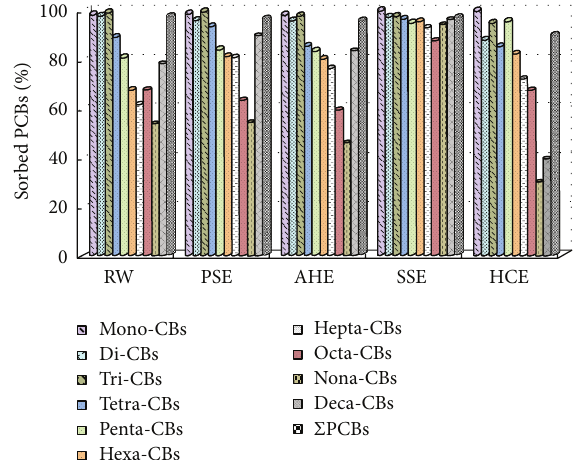
Figure 3: Distribution of PCBs in the adsorbed phase of the influent and effluent of each treatment stage.